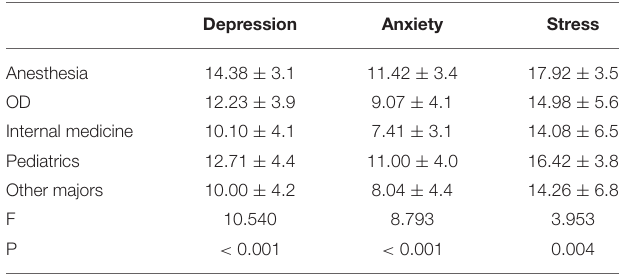
TABLE 3 | The comparison of each emotional state of DASS among different